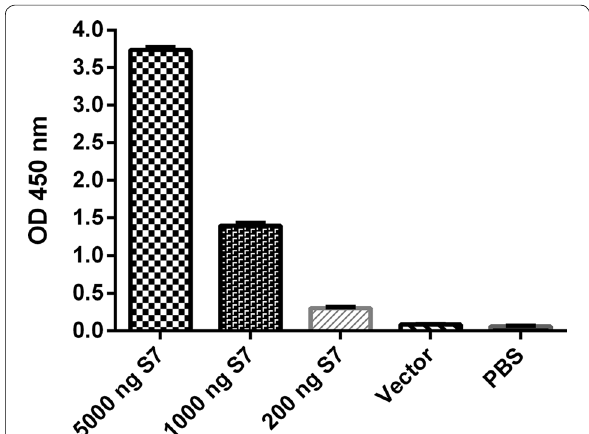
Fig. 5 The binding activity and specificity of the S7 antibody were analyzed by indirect ELISA. 5, 1 and 0.2 μg/ml final concentrations of S7 antibody were added to PEDV spike protein-coated microplates, and the binding of S7 antibody was detected with HRP-streptavidin. Protein extracts from E. coli transformed with the modified pET-25b vector were used as a negative control, and PBS solution was used as